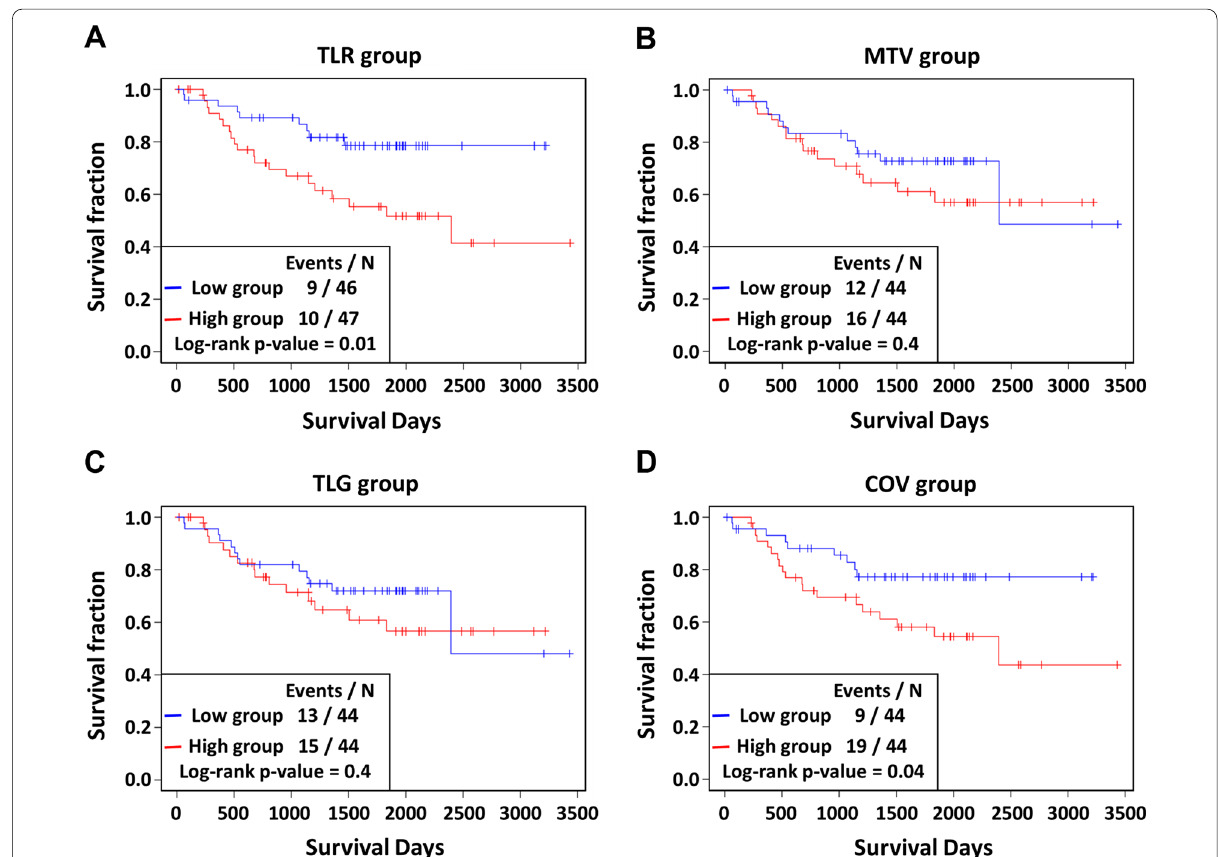
Fig. 6 Prognostic value of 18 F‑FDG PET parameters. Kaplan–Meier curves of each A TLR, B MTV, C TLG and D COV group divided by the median values of the parameters for overall survival. Red, high group; blue, low group. The boxes in each survival curve show the number of dead and the total number of patients for groups and the p values according to log‑rank tests